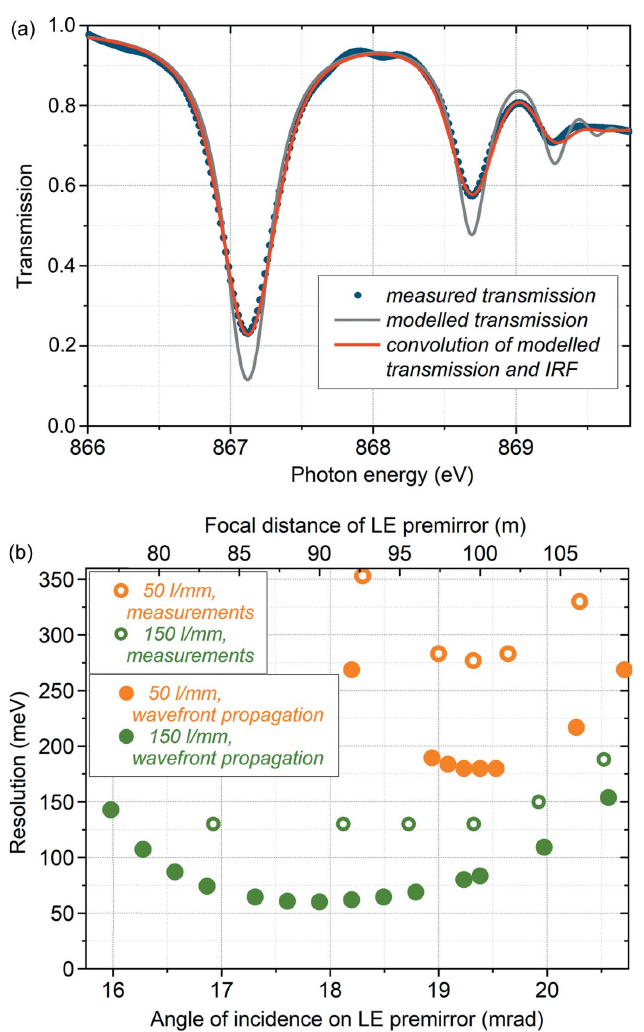
Figure 6 Resolution measurements and longitudinal focusing. ( a ) Transmission spectrum of Ne around the K -edge; circles represent measured transmission spectra; grey lines – modelled transmission; red lines – resulting convolution of modelled transmission with the monochromator IRF. ( b ) Resolution optimization at the Ne K -edge by aligning the angle of incidence of the LE premirror; operation in first diffraction order.